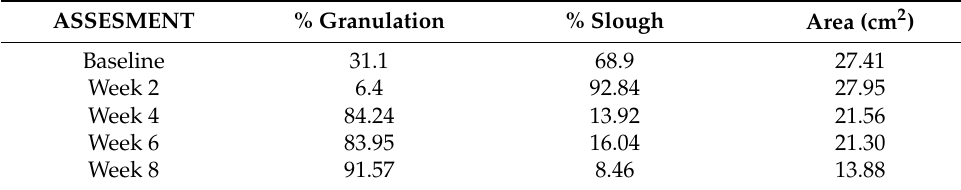
Figure 12. Evolution of tissue types. Case 6. Figure 12 . Evolution of tissue types. Case 6. Table 4. Evolution in the percentage of tissue types and areas Case Table 4. Evolution in the percentage of tissue types and areas Case 6.